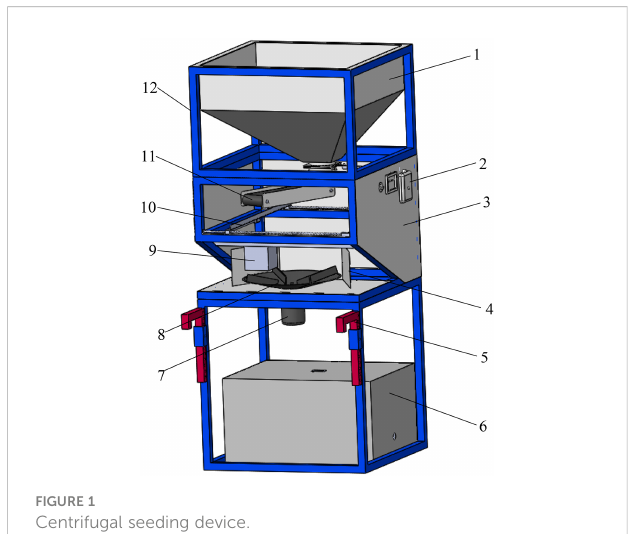
FIGURE 1 Centrifugal seeding device.